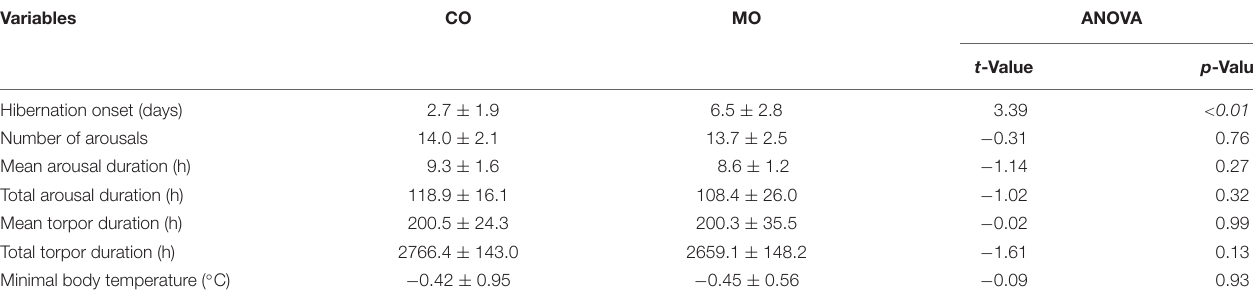
TABLE 5 | Variables of hibernating patterns of garden dormice fed diets enriched with either n-6 fatty acids (“CO”) or n-3 fatty acids (“MO”). Variables CO